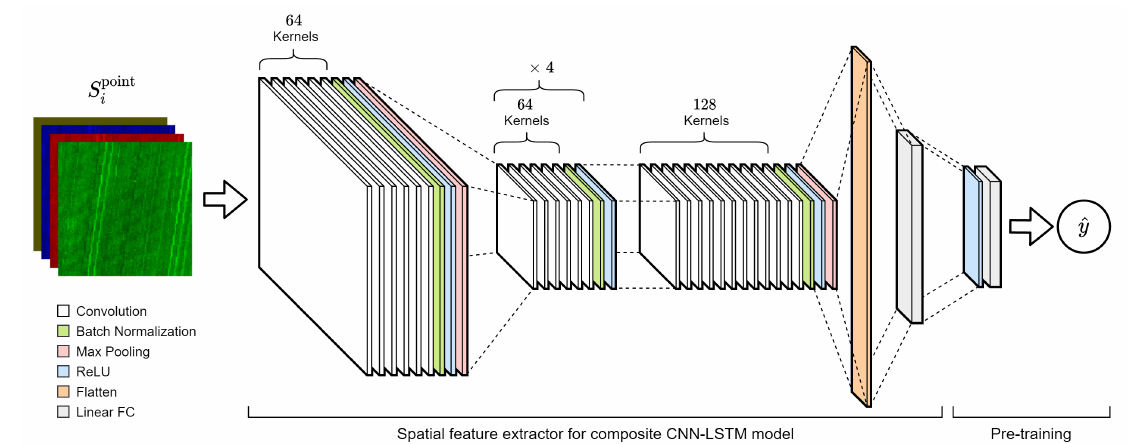
Figure 3. The spatial feature extracting CNN of the CNN-LSTM composite model, i.e., the pretrained CNN. The model is similar to the best performing model of [2]. Alterations in the FC layer composition had to be made to provide sufficient features for the LSTM utilizing the CNN as its input